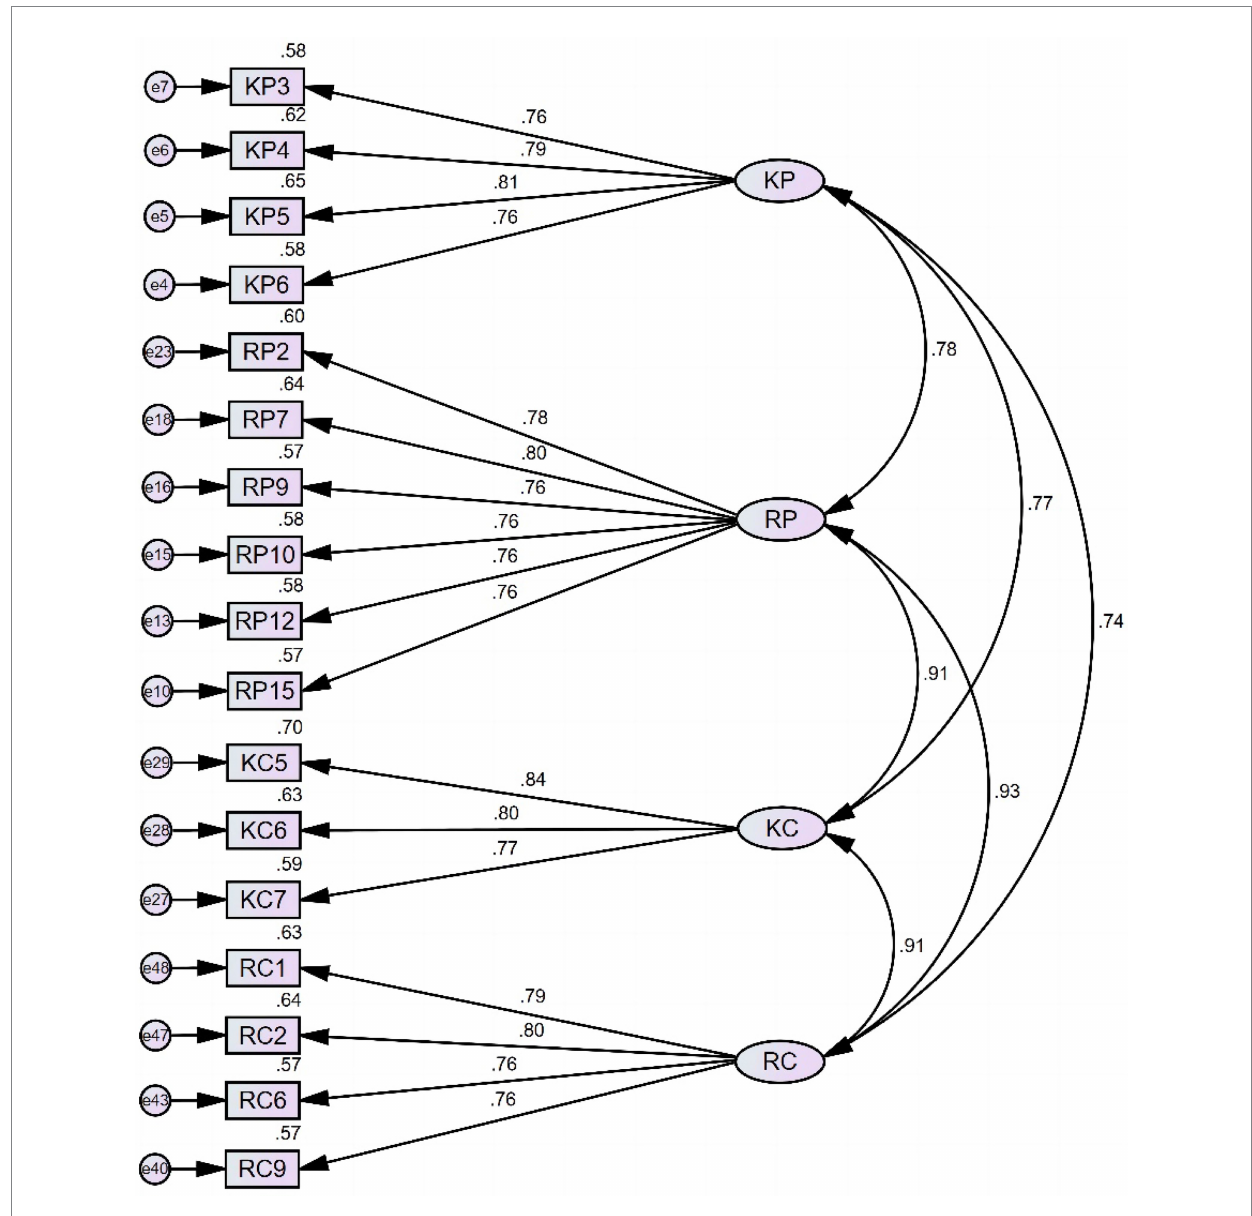
FIGURE 3 Model 3 with standardized estimates.